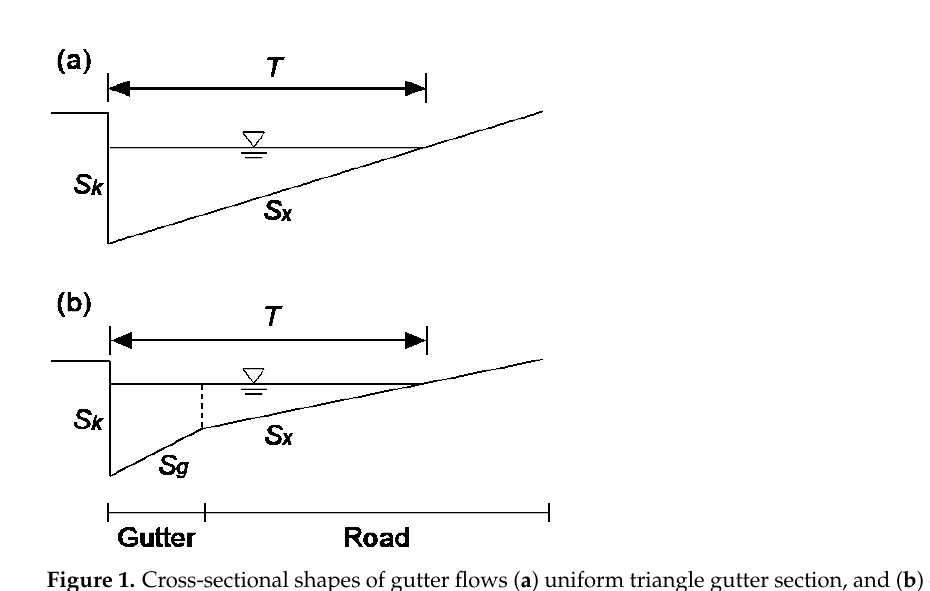
: transverse slope 𝑆𝑆 𝑥𝑥